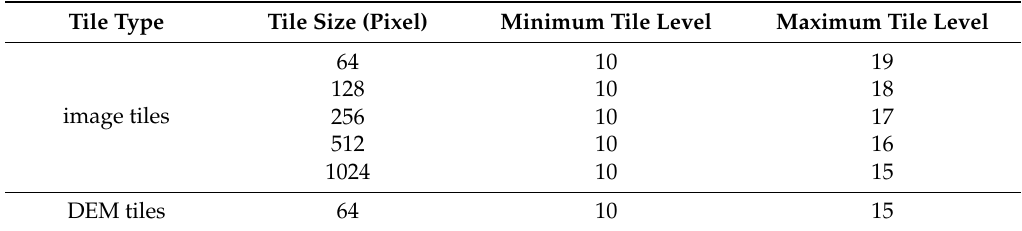
Table 2. Specifications of the tile data used in the experiment.